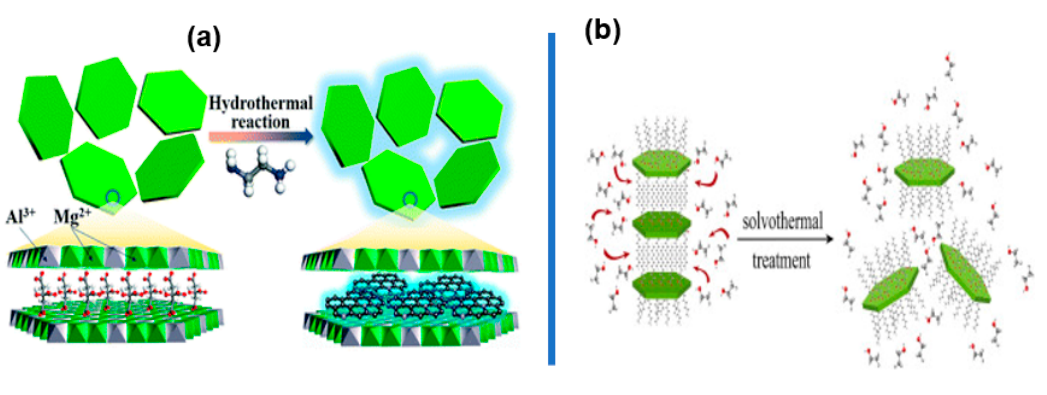
Figure 7. Schematic representation of ( a ) hydrothermal method and ( b ) solvothermal treatment of layered double hydroxide (LDH). Reproduced with permission from Reference [70,71]. Copyrights 2017 and 2019, RSC and